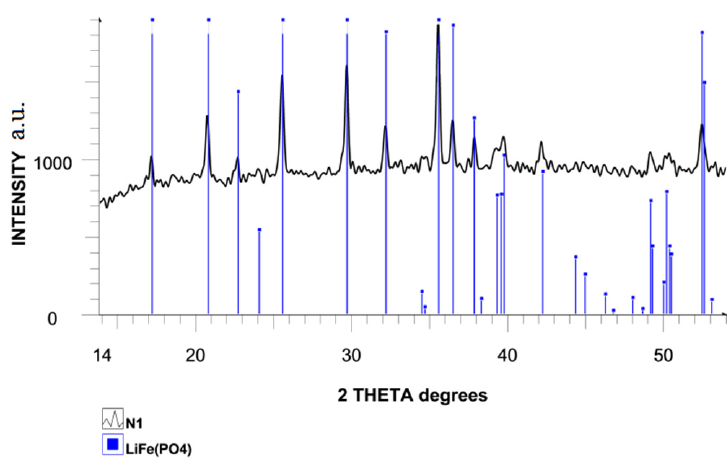
Figure 2. X-ray diffraction (XRD) pattern of synthesized LiFePO 4 /C. Table 1. The lattice parameter values of the LiFePO 4 /C sample and standard data.